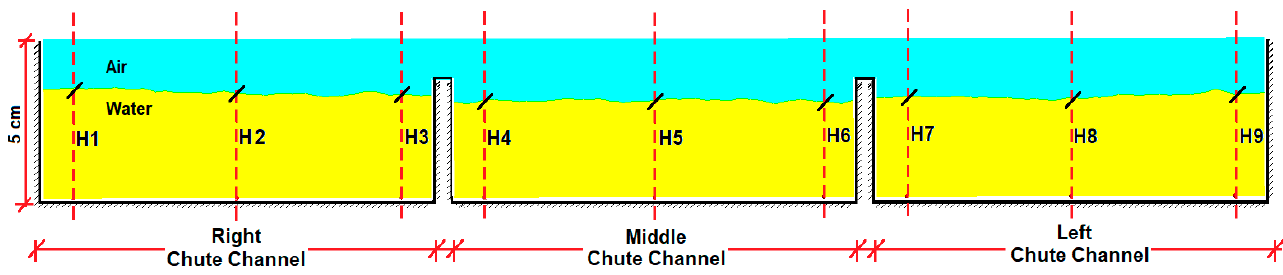
Figure 23. CFD water depth contours for Cross-section 3.